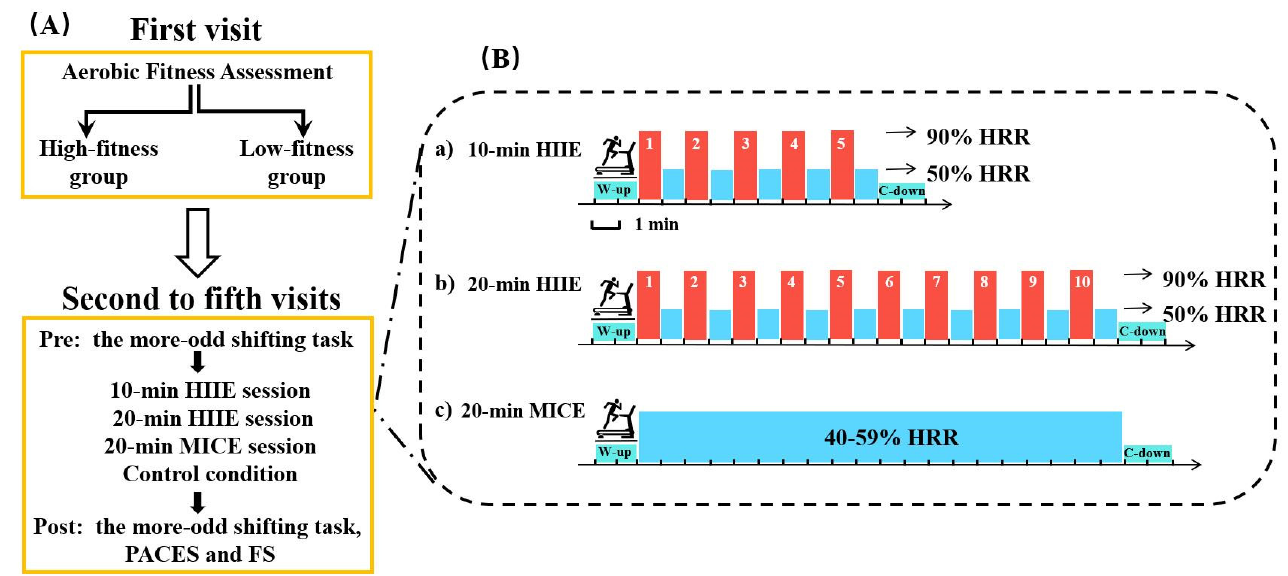
Figure 1. ( A ) the study design; ( B ) the experimental protocol. HIIE: high-intensity interval exercise; MICE: moderate-intensity continuous exercise; W-up: warm up; C-down: cool down.